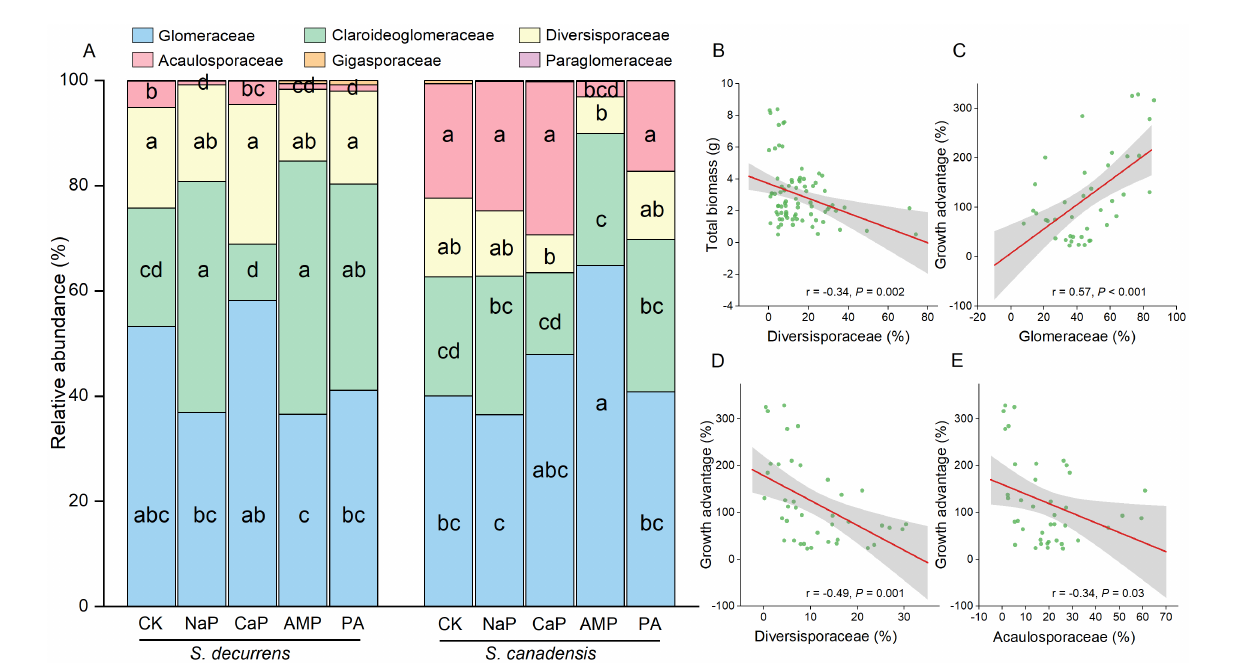
FIGURE 4 (A) Relative abundance of AMF at the family level of S. decurrens and S. canadensis under five P treatments. CK: no P addition; NaP: sodium dihydrogen phosphate; CaP: hydroxyapatite; AMP: adenosine monophosphate; PA: myo-inositol hexakisphosphate. The different lower-case letters among S. decurrens and S. canadensis denote significant differences at p < 0.05. (B) Pearson correlations between the relative abundance of Diversisporaceae and plant growth. Pearson correlations between the relative abundance of (C) Glomeraceae, (D) Diversisporaceae, and (E) Acaulosporaceae and the growth advantage of S. canadensis over S. decurrens . The gray ribbons represent the 95% confidence intervals.